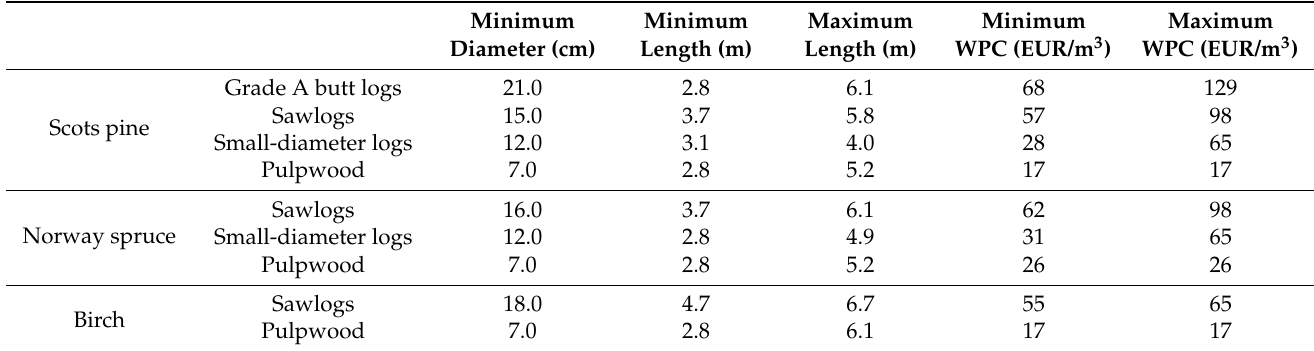
Table 3. Minimum and maximum parameters used in